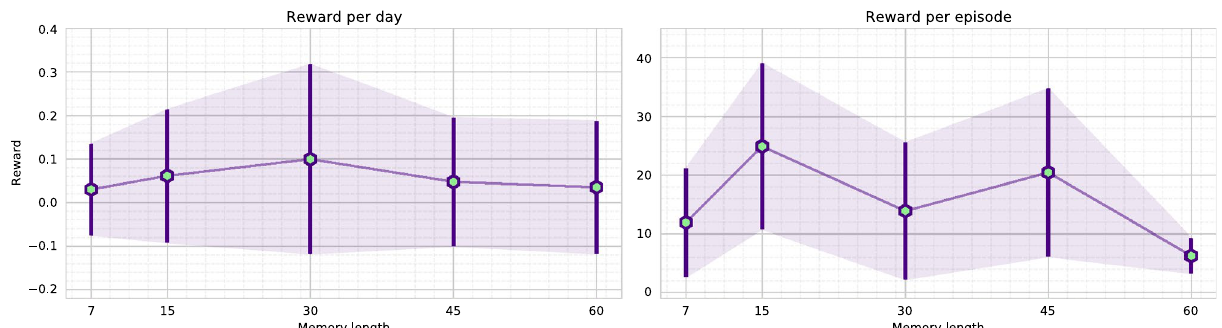
Figure 13. The left graph exhibits the agent’s reward points on average (per day), and the right illustrates total economic gain for an episode. It is guaranteed that the comparisons are executed in the same environmental